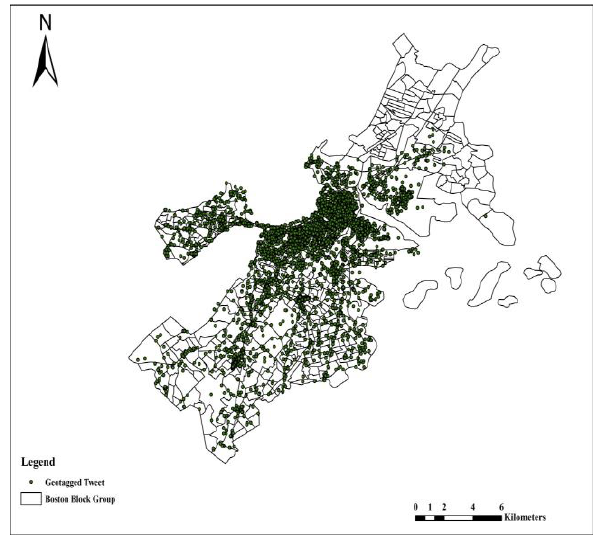
Figure 1. Tweet's Spatial Distribution in